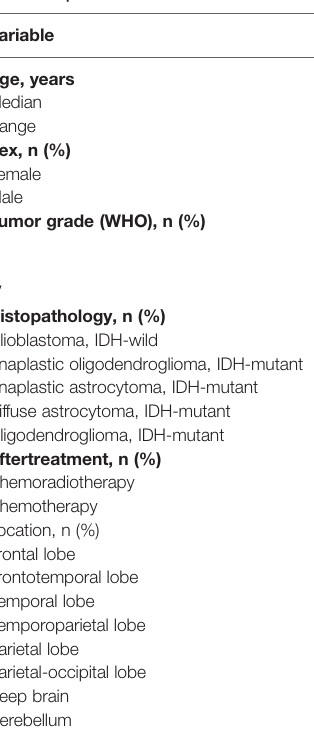
TABLE 1 | Clinical